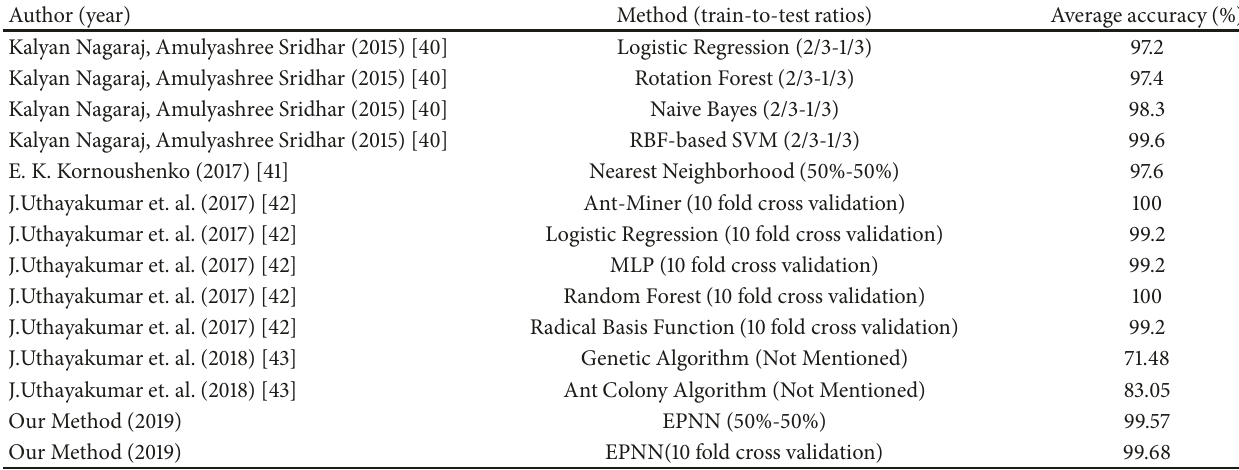
Table 11: Classification accuracies for Qualitative Bankruptcy dataset obtained by other single classification methods in relative literatures.